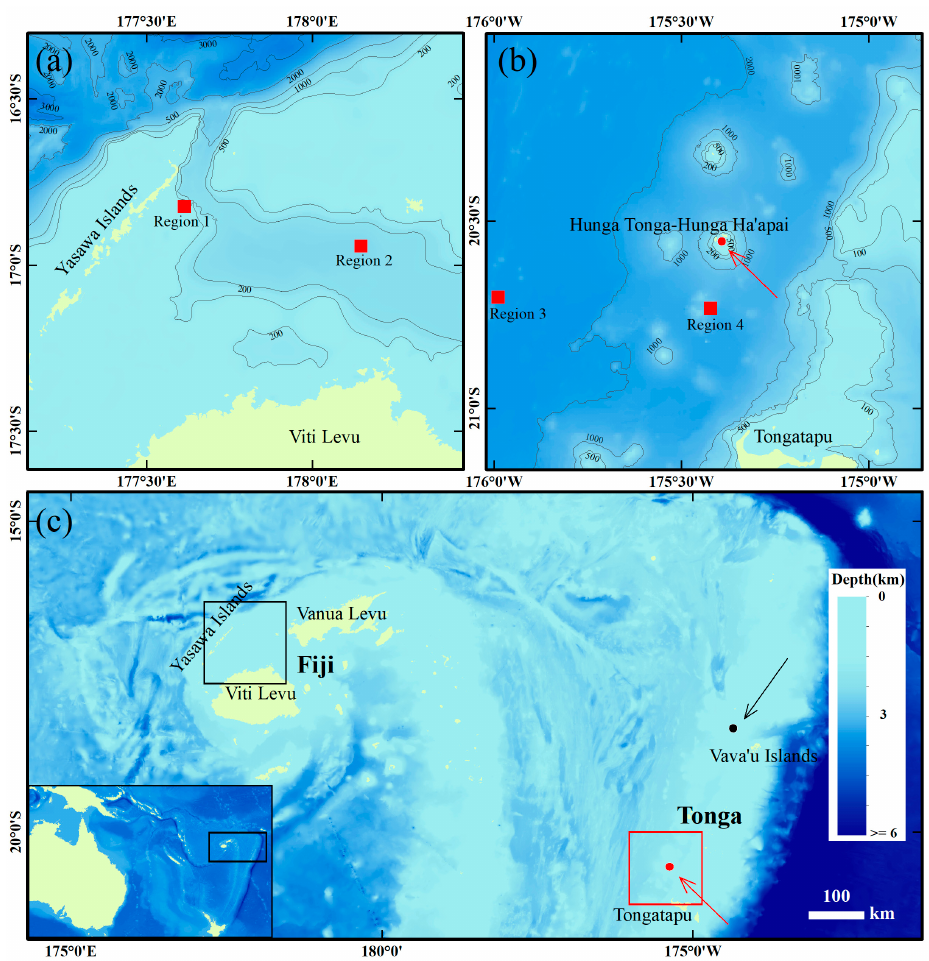
Figure 1. Study area near ( a ) Fiji Yasawa islands (study case 1) and ( b ) Hunga Tonga island (study case 2). The red arrow points to the location of the Hunga Tonga-Hunga Ha’apai volcano (volcano number: 243040) for the January 2022 eruption. ( c ) The two regions are located in the Southwest Pacific region, with the extent of panels a and b marked in black and red boxes, respectively. The pumice near the Fiji Yasawa Islands in panel a was actually from the eruption of volcano 0403-091 (black arrow pointed location) in August 2019, ~300 km from the eruption location for case 2. The locations marked by red squares in panels a and b are used in Section 3.3 to diagnose pumice raft index threshold for separating pumice and water.